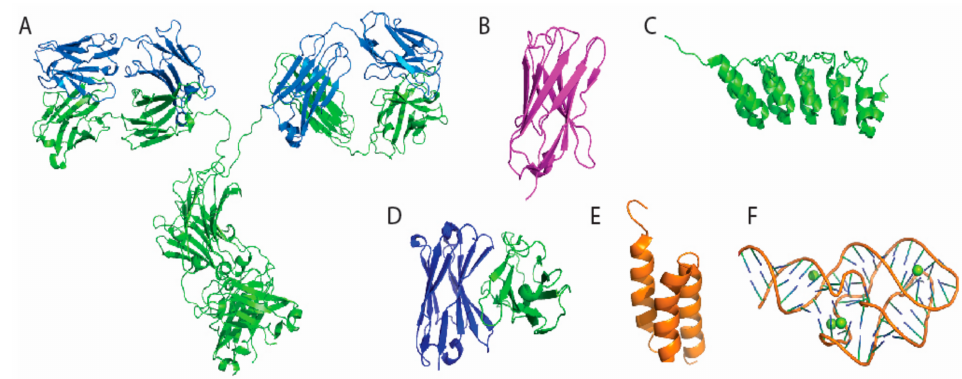
Figure 1. Overall structure of Ab and alternative recombinant binder scaffolds used in biosensors. ( A ) IgG2a monoclonal antibody with two heavy chains colored in green and two light chains colored in blue (PDB:1IGT) [18]; ( B ) The green fluorescent protein (GFP)-VHH (PDB: 3OGO) [19]; ( C ) DARPin against tubulin beta chain (PDB: 4DUI) [20]; ( D ) anti-fluorescein ScFv (PDB: 1X9Q) [21]; ( E ) human epidermal growth factor receptor 2 (HER2) binding affibody (PDB: 2KZJ) [22]; ( F ) 5-hydroxytryptophan aptmer (PDB: 5KPY) [23]. We used PyMol to generate all the structures in this figure.